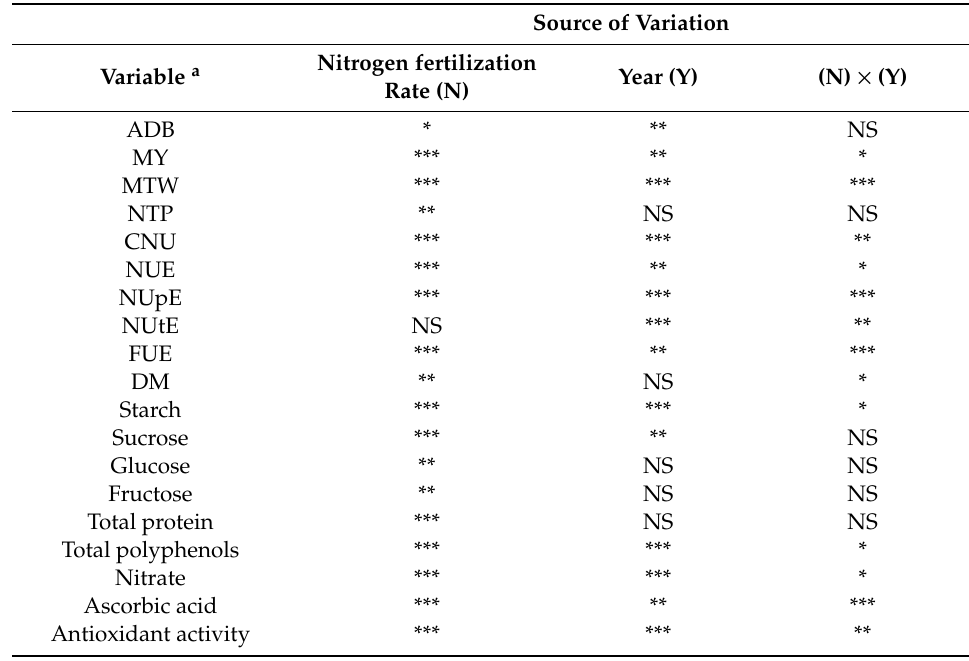
Table 3. Summary of statistical significance from analysis of variance for the aboveground dry biomass, yield components, N e ffi ciency indices and tuber chemical characteristics.